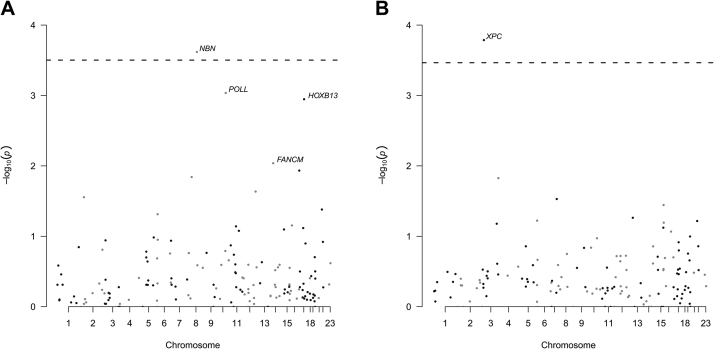
SKAT-O results for (A) case–control and (B) aggressive phenotypes. The dashed line denotes the Bonferroni-corrected candidate-level significance threshold for each phenotype, according to the number of genes containing two or more tier 1 and 2 PTVs included in the analysis (159 and 146 respectively). Genes are labelled at p < 0.05. PTV = protein truncating variant.